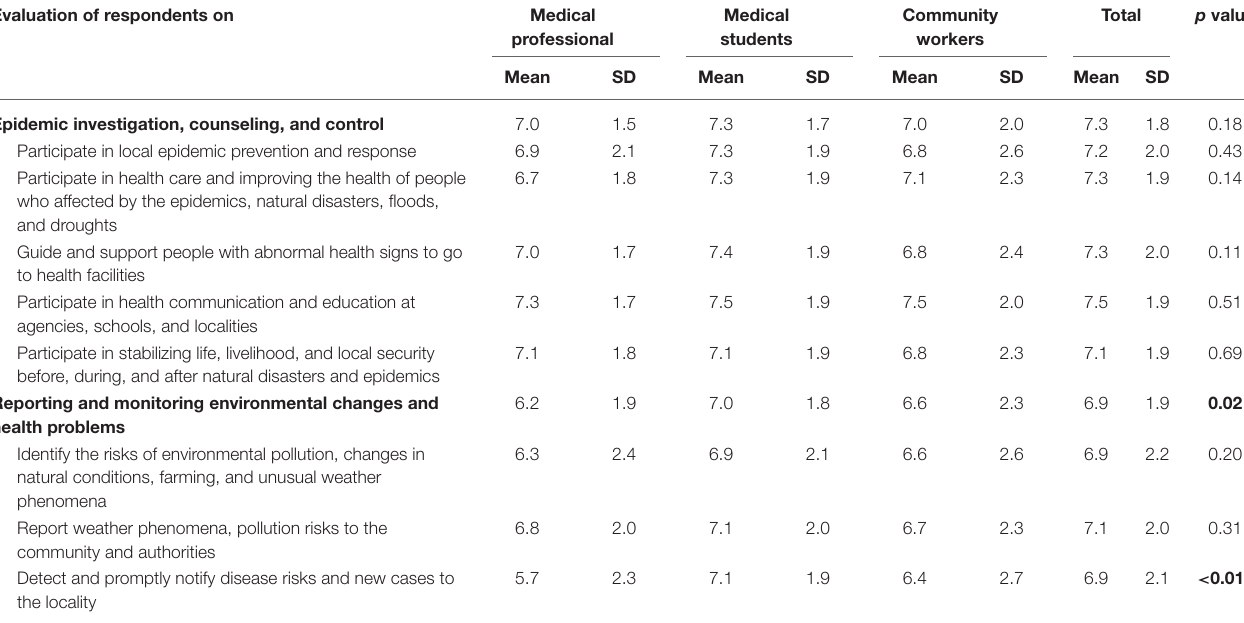
TABLE 4 | The perceived efficiency of involving community service workers in health care–related activities at grassroots levels. Evaluation of respondents